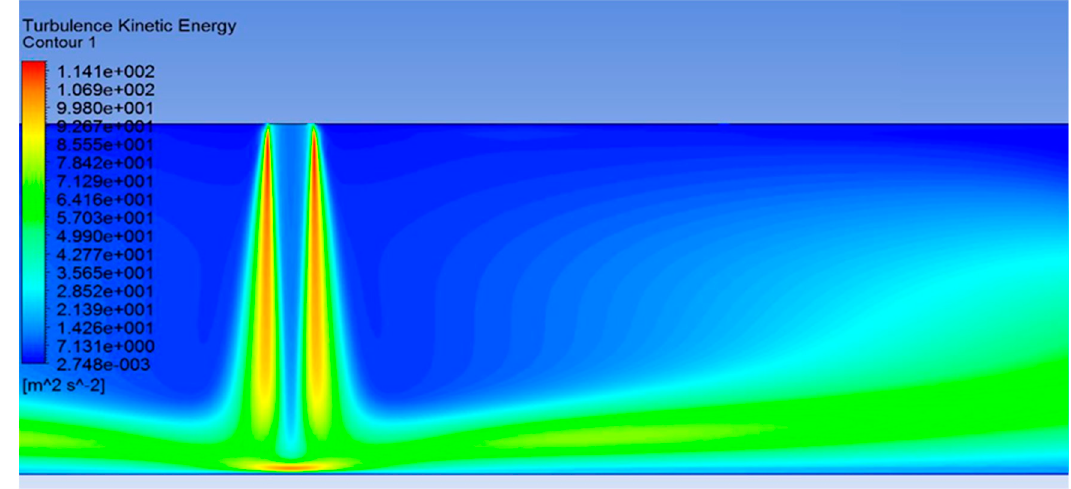
Figure 8. Turbulence kinetic energy contours of the single slot jet at H/B = 8, Re = 1.1 × 10 4 , with k- ε model.